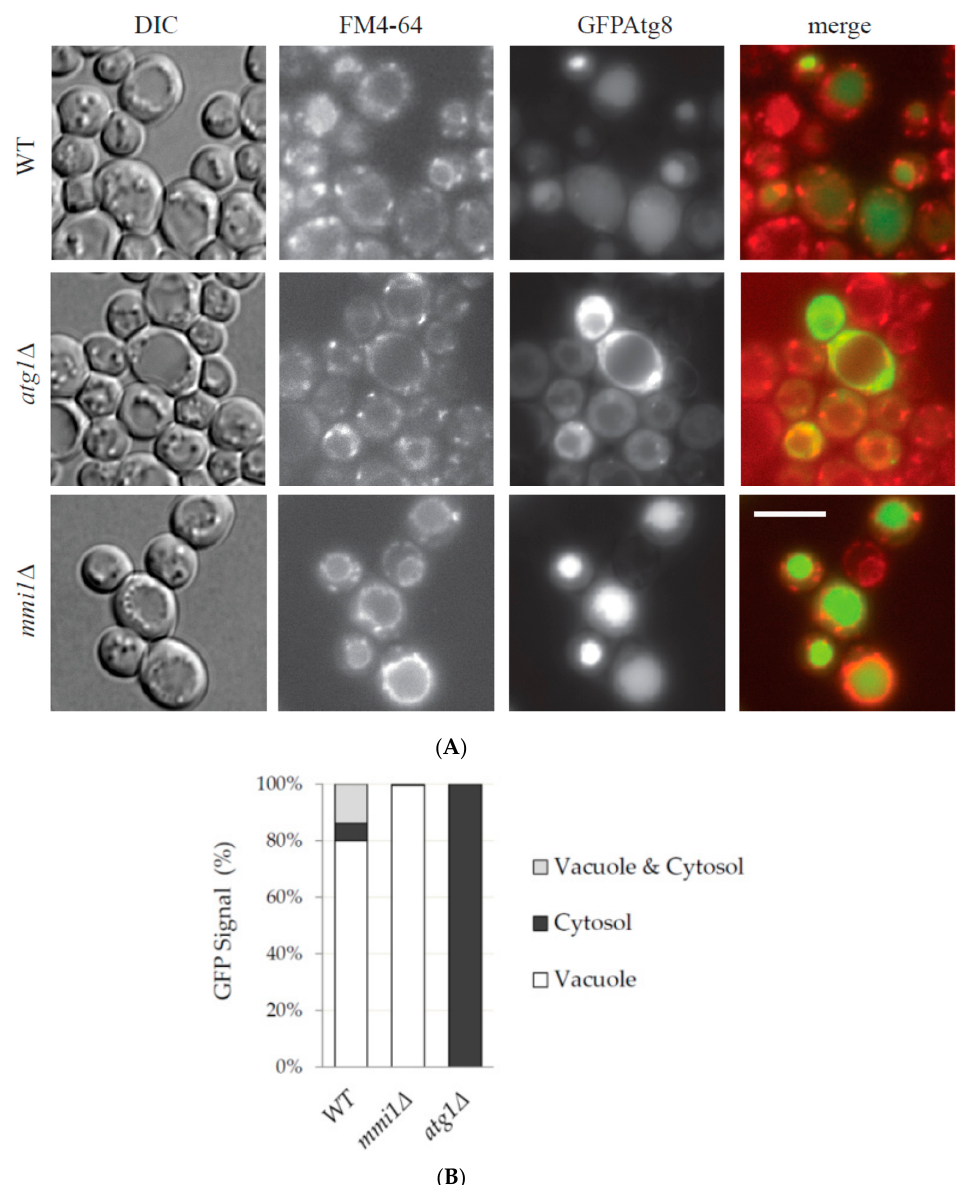
Figure 3. Fluorescence microscopy detection of a higher GFP-Atg8 processing in mmi1 ∆ cells upon rapamycin treatment. ( A ) The same samples of WT, atg1 ∆ , and mmi1 ∆ cells treated with rapamycin